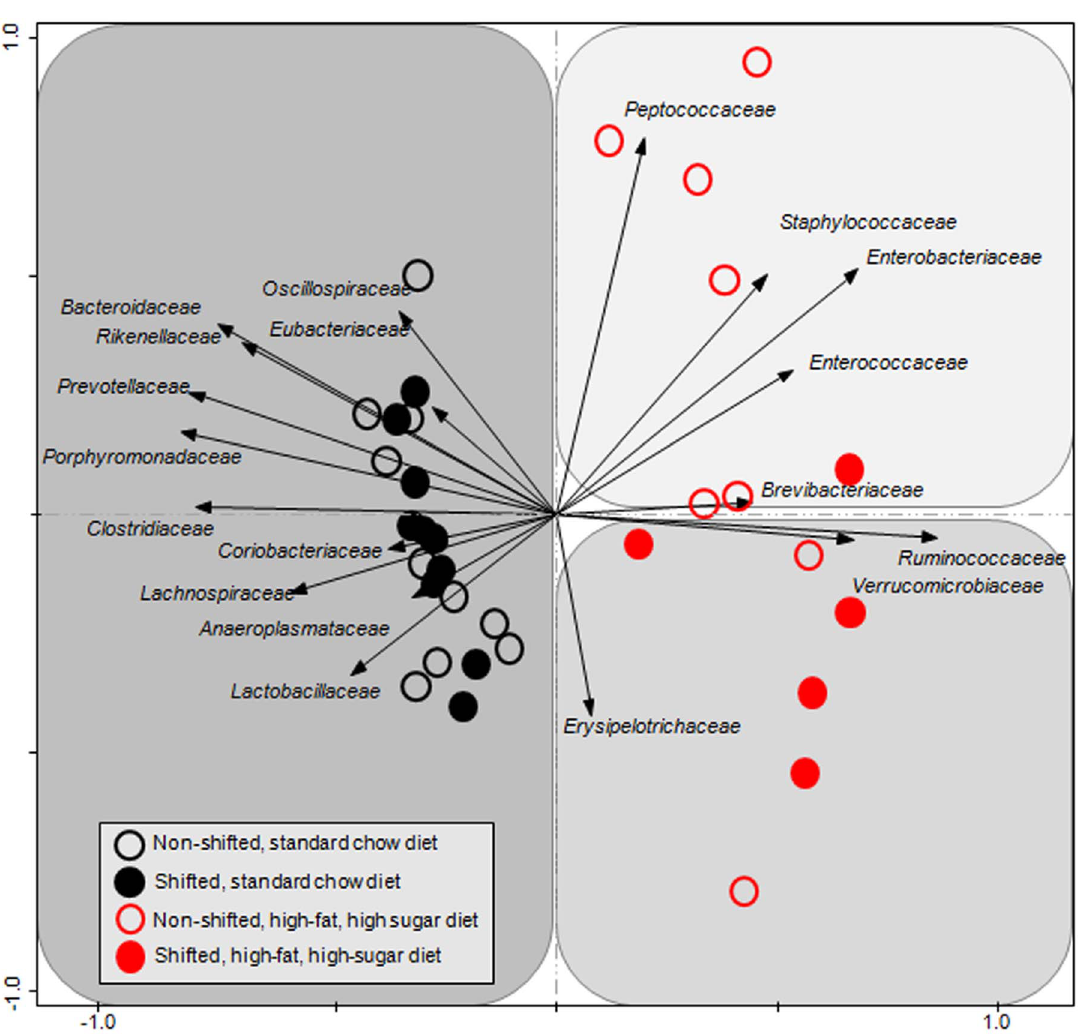
Figure 7. Family-level gut microbial community analysis. The composition of bacterial communities from each sample, grouped at the family level, was analyzed using principal component analysis of log-transformed and standardized data, as described in the text. Vectors, or arrows, point in the direction of the steepest increase of values for the corresponding family. The angle between arrows indicates approximated correlation ( . 90 u indicates negative correlation). The samples are indicated with individual symbols, according to treatment, and the distance between symbols approximates the dissimilarity of their microbial communities, as measured by Euclidean distance. PCA axes 1 and 2 explain 47.51% of the variation.